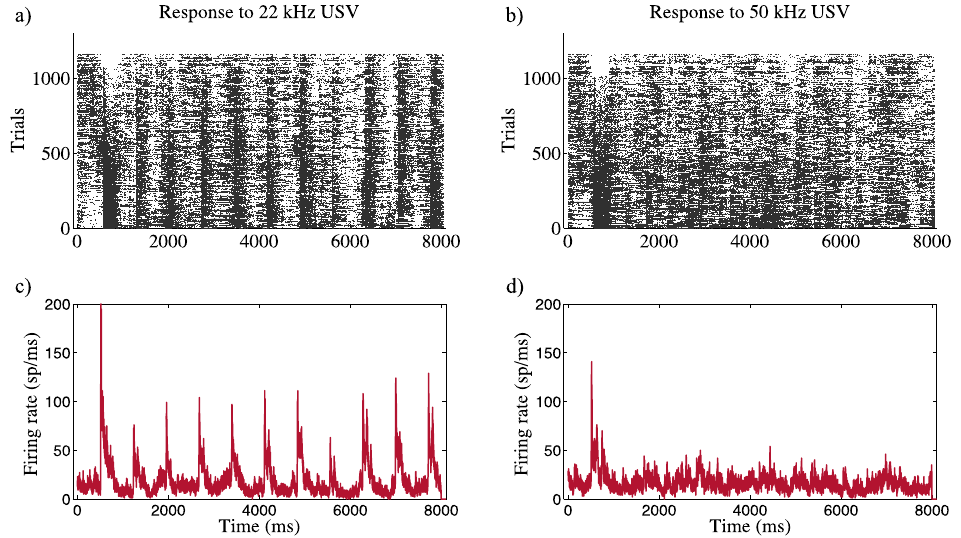
Figure 6. Raster plots and relative PSTHs for the multiunit activity of A1 to ultrasound at 22 kHz ( a , c ) and 50 kHz ( b , d ). The baseline was evaluated at 510 ms after USV onset; subsequently, an inter-stimulus interval (ISI) was used following the USV to avoid overlap during the 20 repetitions. The spectro-temporal characteristics of the neuronal discharge pattern were correlated with the acoustical structure of the vocalizations.